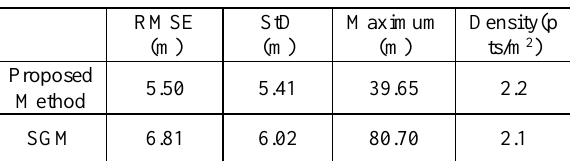
Fig.7 The DSM from the SGM method in Vaihingen